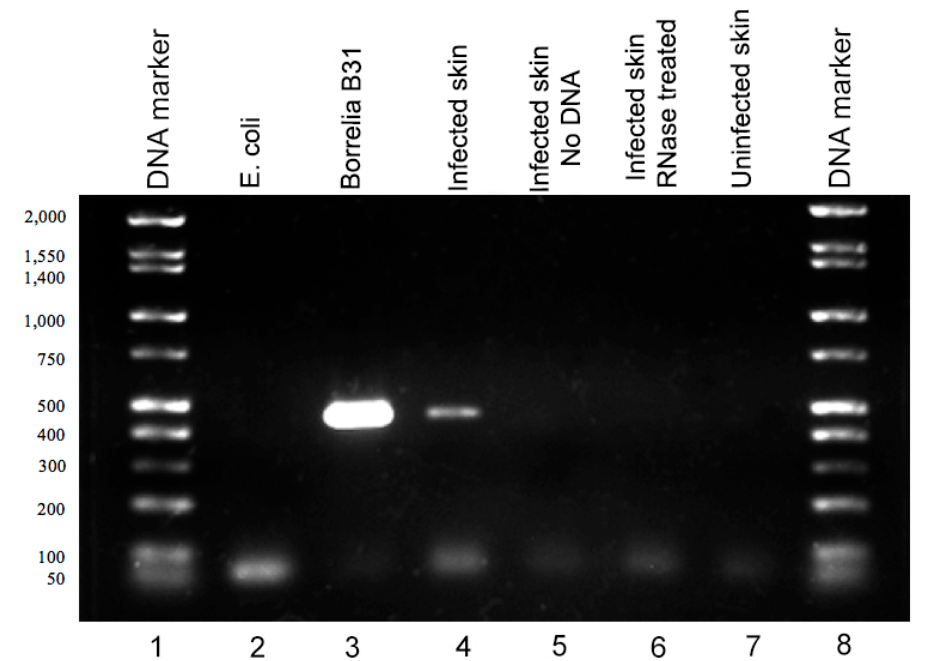
Figure 3. Detection of B. burgdorferi RNA in infected murine ex vivo skin biopsies. Gel electrophoresis